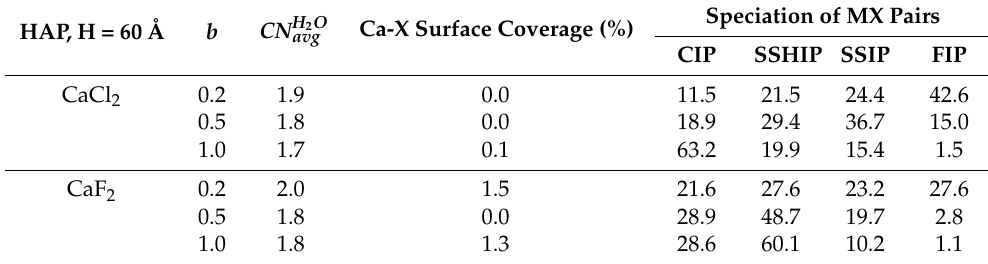
Table 5. Average coordination number of the surface calcium ions with the water molecules, CN H 2 O avg . Hydroxyapatite surface coverage with respect to the halide ions (X = Cl or F). Speciation of calcium halide ion pairs in solution: contact ion pairs (CIP), solvent-shared ion pairs (SSHIP), solvent-separated ion pairs (SSIP), and free ion pairs (FIP). Concentration ( b ) in mol · kg − 1 . HAP, H = 60 Å b CN H 2 O